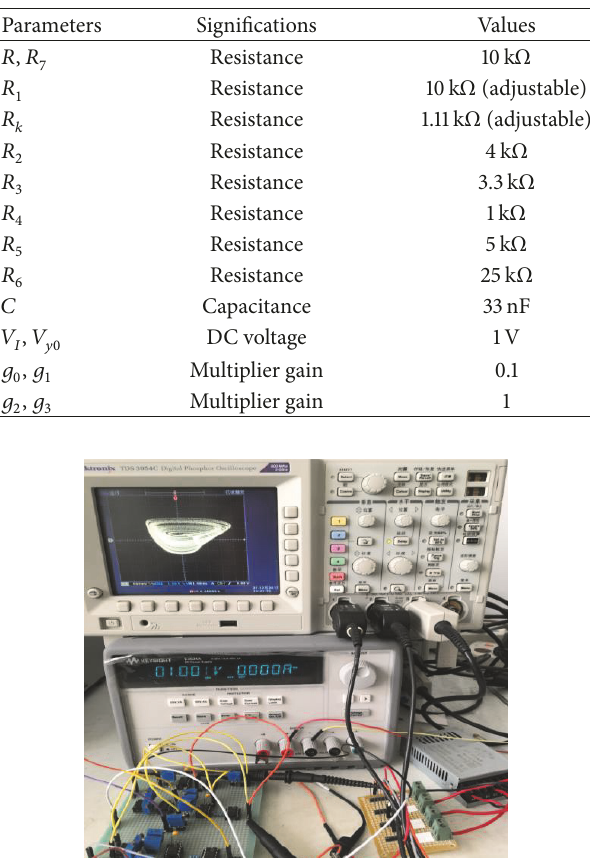
Table 1: Circuit parameters of the memristive HR neuron model for breadboard experiments.